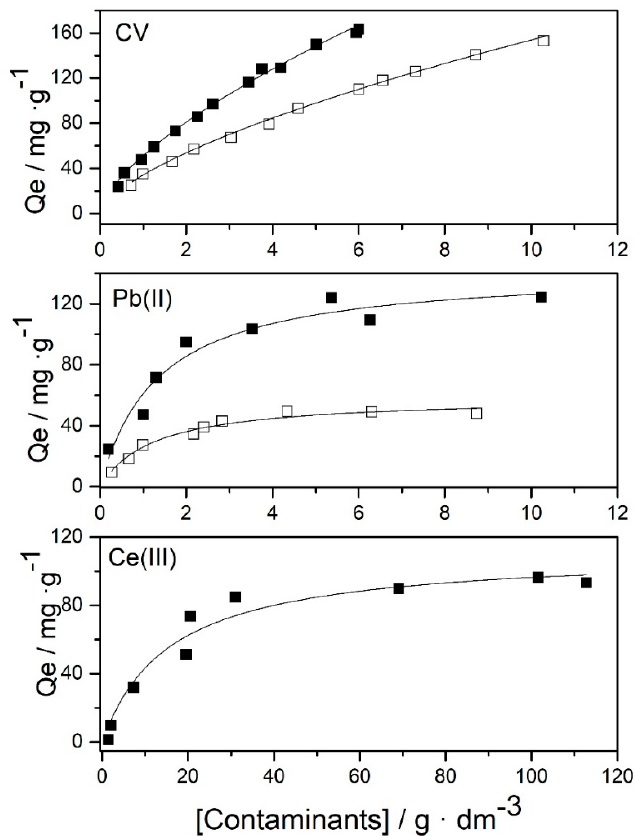
Figure 4. Adsorption isotherm of CV, Pb(II) and Ce(III) onto K10-montmorillonite clay mineral (K10-Mt) performed at pH = 6.0 ( ■ ) and pH = 2.0 ( □ ). Lines correspond to the fit by Freundlich model for CV and Langmuir model for metals ions, respectively. Table 2. Sorption parameters for the adsorption isotherms of the contaminants onto K10-Mt.